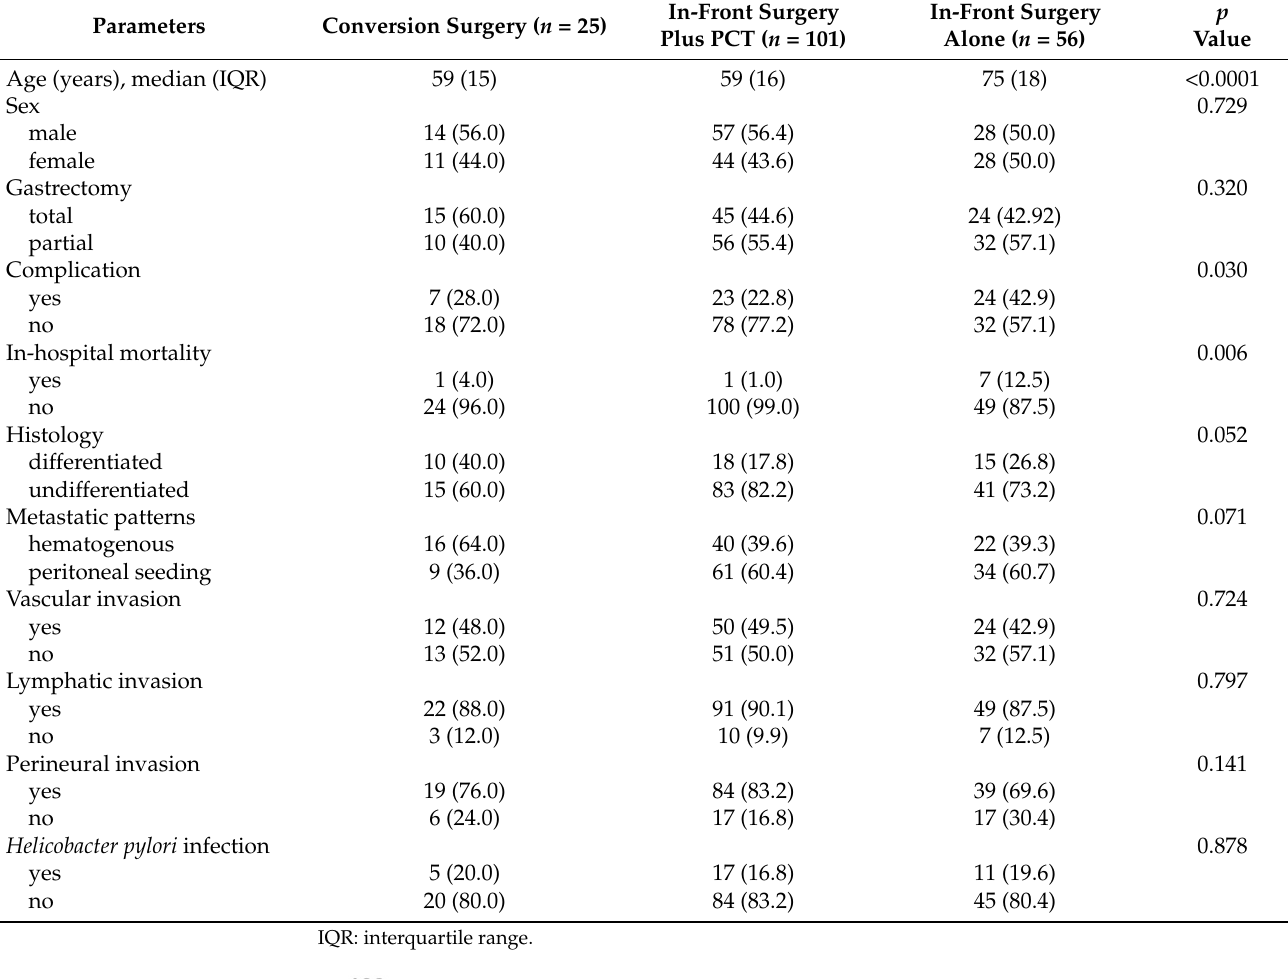
Table 1. Comparison of the clinicopathological parameters between patients that underwent conver- sion surgery, in-front surgery plus palliative chemotherapy (PCT), and in-front surgery alone.